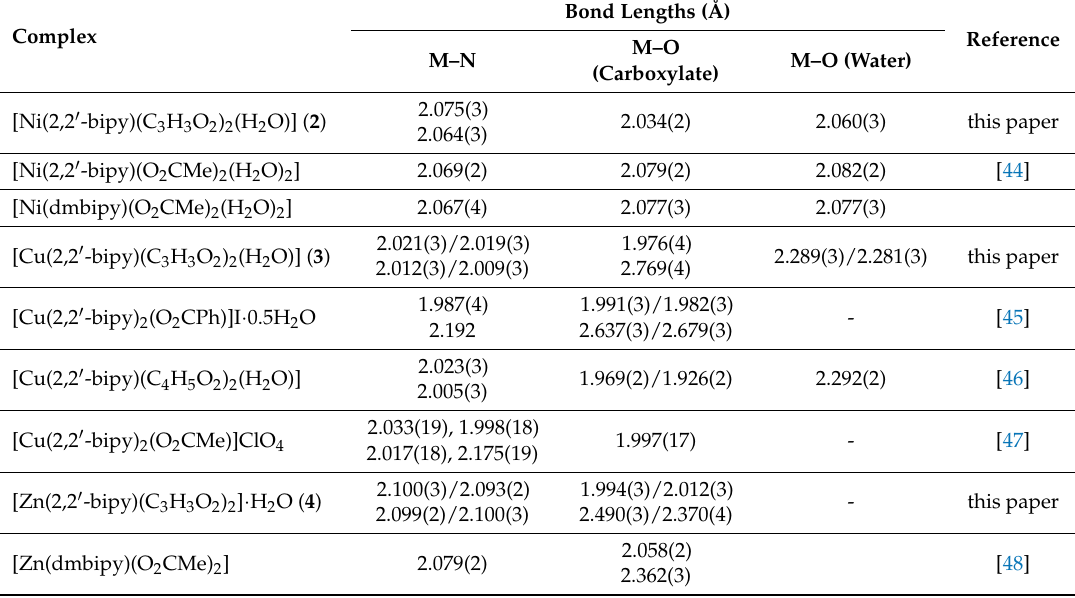
Table 5. Selected bond lengths for complexes ( 2 )–( 4 ) and similar